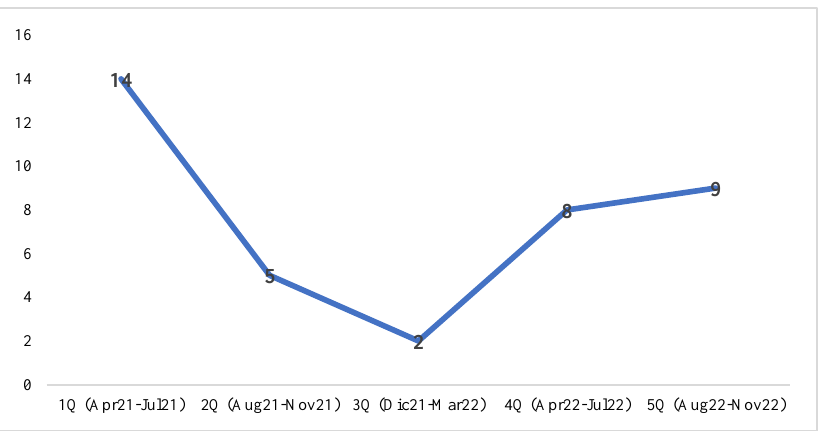
Figure 1. Number of BC patients evaluated for NGS testing over a 20-months period. All patients were female, with a median age at diagnosis of 45 (IQR, 42 – 51) and at our evaluation of 52 (IQR, 48 – 59). Most patients had HR + cancers (55%) followed by TNBC (39%). ECOG performance status at the time of our evaluation was good (0 or 1) in 97% of the study population although they were heavily pre-treated.